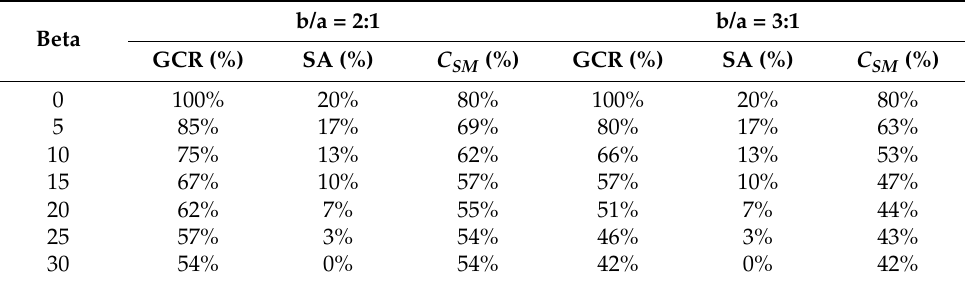
Table 5. The ground coverage coefficient and service Table 5 . The ground coverage coefficient and service area.